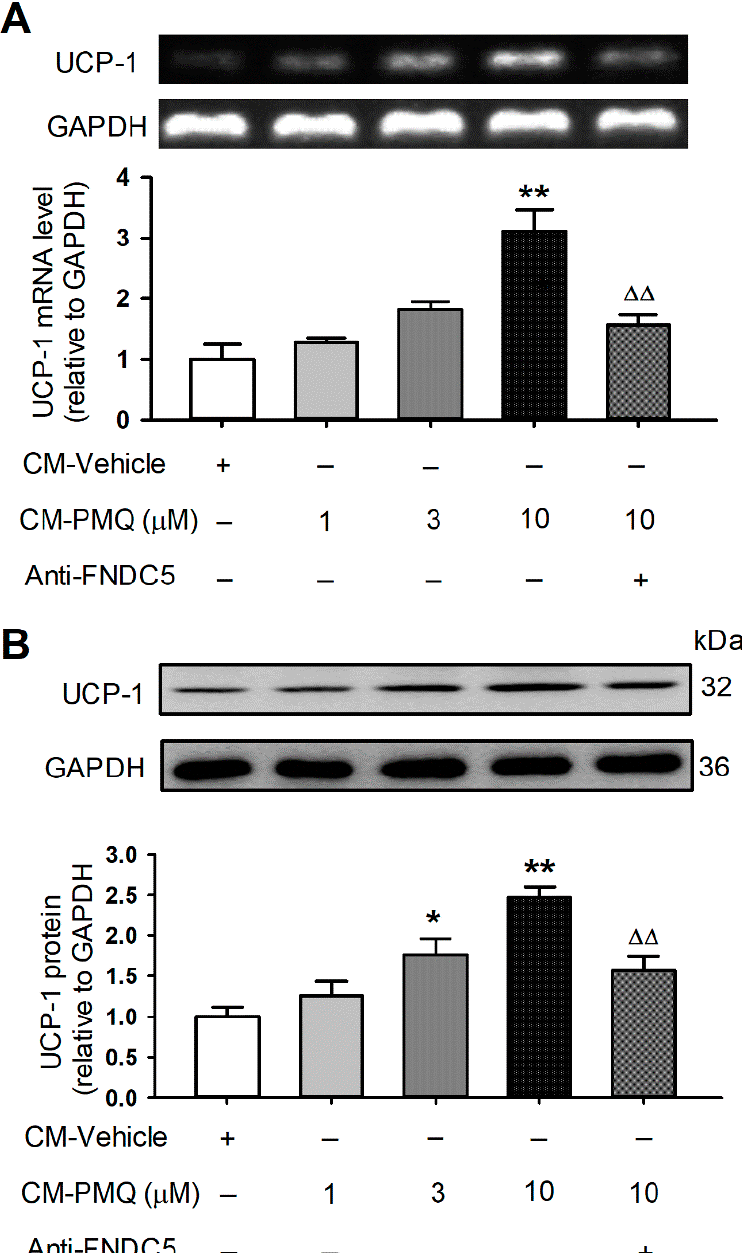
Figure 5. PMQ promotes UCP-1 expression in 3T3-L1 cells by FNDC5/irisin pathway. 3T3-L1 cells were treated with CM-vehicle, CM-PMQ (1, 3, 10) and CM-PMQ10 plus FNDC5 antibody (anti-FNDC5). ( A ) Relative mRNA levels of UCP-1 in 3T3-L1 cells. n = 3. ( B ) UCP-1 protein levels in 3T3-L1 cells. n = 4. * p < 0.05, ** p < 0.01 vs CM-vehicle; ΔΔ p < 0.01 vs. CM-PMQ10. Data are expressed as means ± SEM.